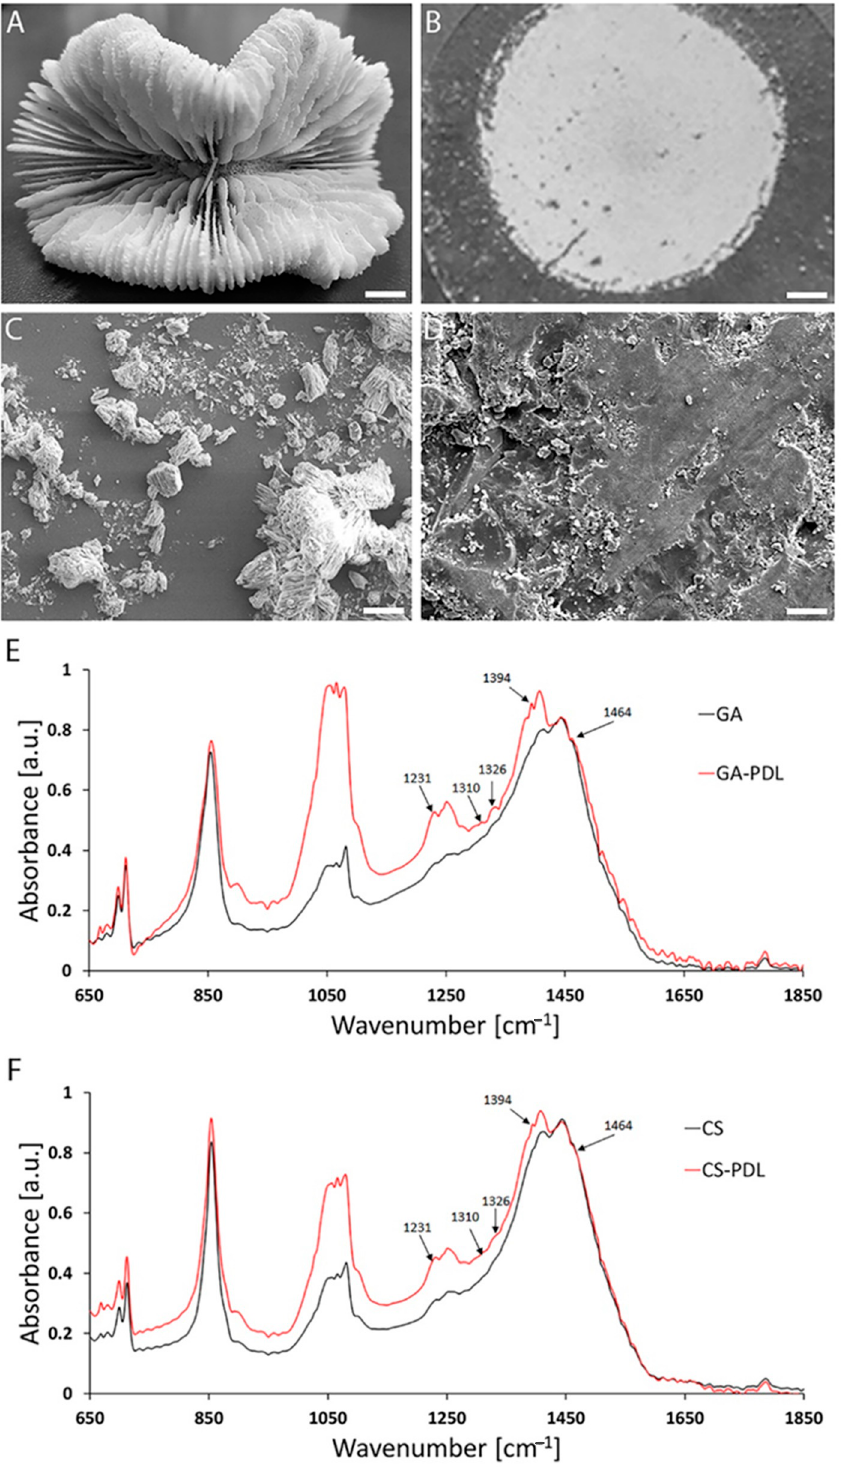
Figure 2. Trachyphyllia geoffroyi (CS) and aragonite (GA) have different surface roughness and they both bind poly-D-lysine (PDL). ( A ) The skeleton of the coral T. geoffroyi. ( B ) A glass coverslip covered with the coral skeleton grains. ( C ) SEM of the coral skeleton grains. ( D ) SEM of GA. ( E , F ) FTIR spectra of GA and CS, respectively. Characteristic PDL peaks are indicated by arrows. Scale: ( A )-2mm; ( B )- 120 μ m. ( C , D )-20 μ m.